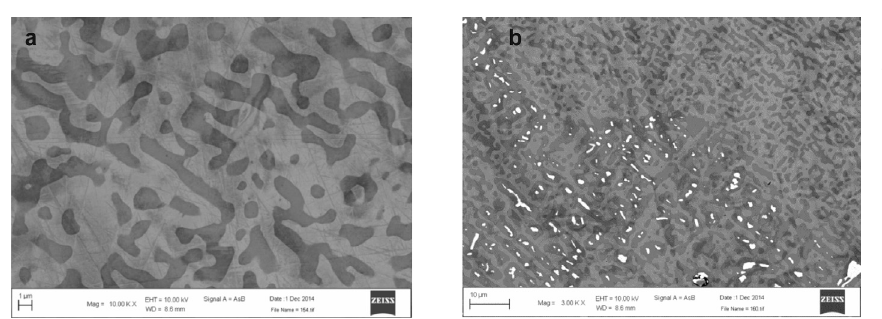
Fig. 5. The microstructure of blade No. 2: a) cross-section in the middle of the blade length, the devel - oped and connected with each other γ’ phase particles separated by the thickened γ phase matrix chan - nels, b) inter-dendritic area, γ–γ’ eutectic system, carbide particles, SEM